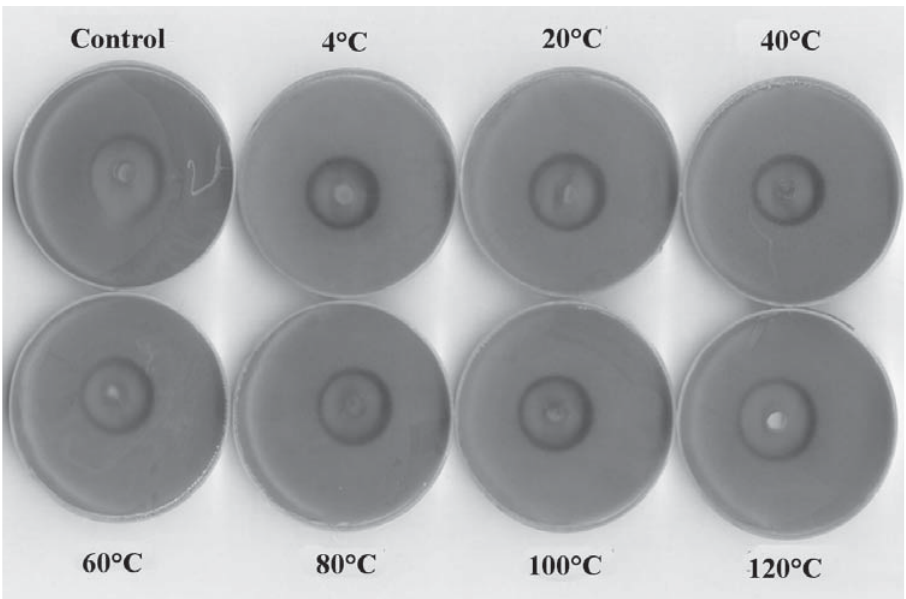
Fig. 2. Stable activity of crude metabolite extract (CMe) against Phaeomoniella chlamydospora at various tempera- tures. Note the resistance to high temperatures